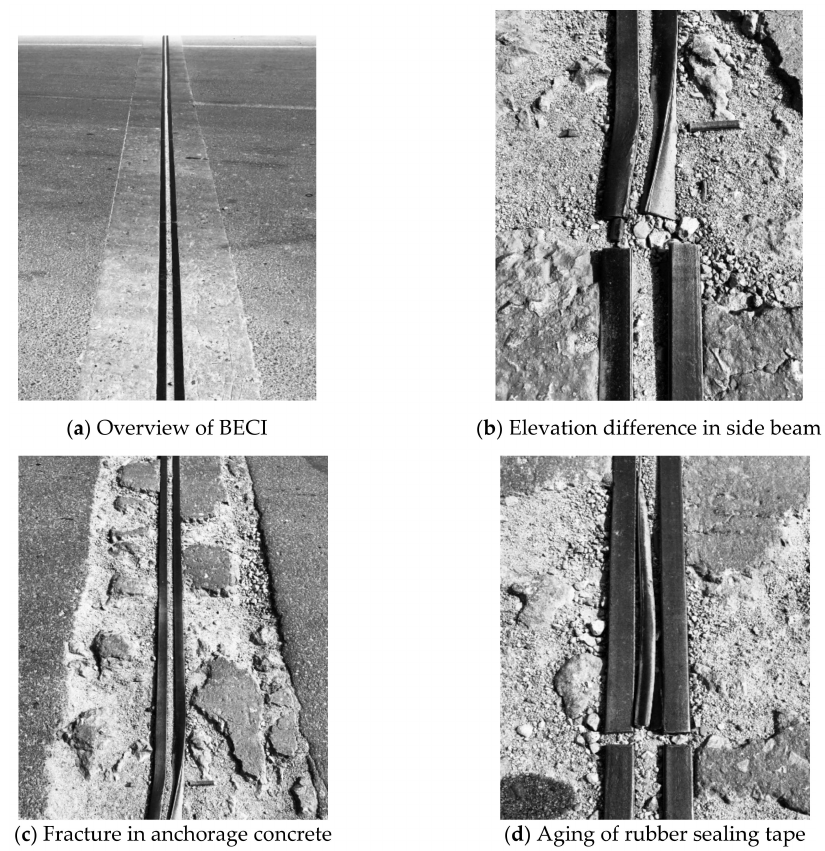
Figure 7. BECI of Guo